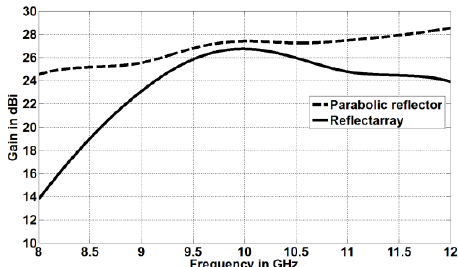
Figure 9: Comparison between the gain of a parabolic reflector antenna and the designed